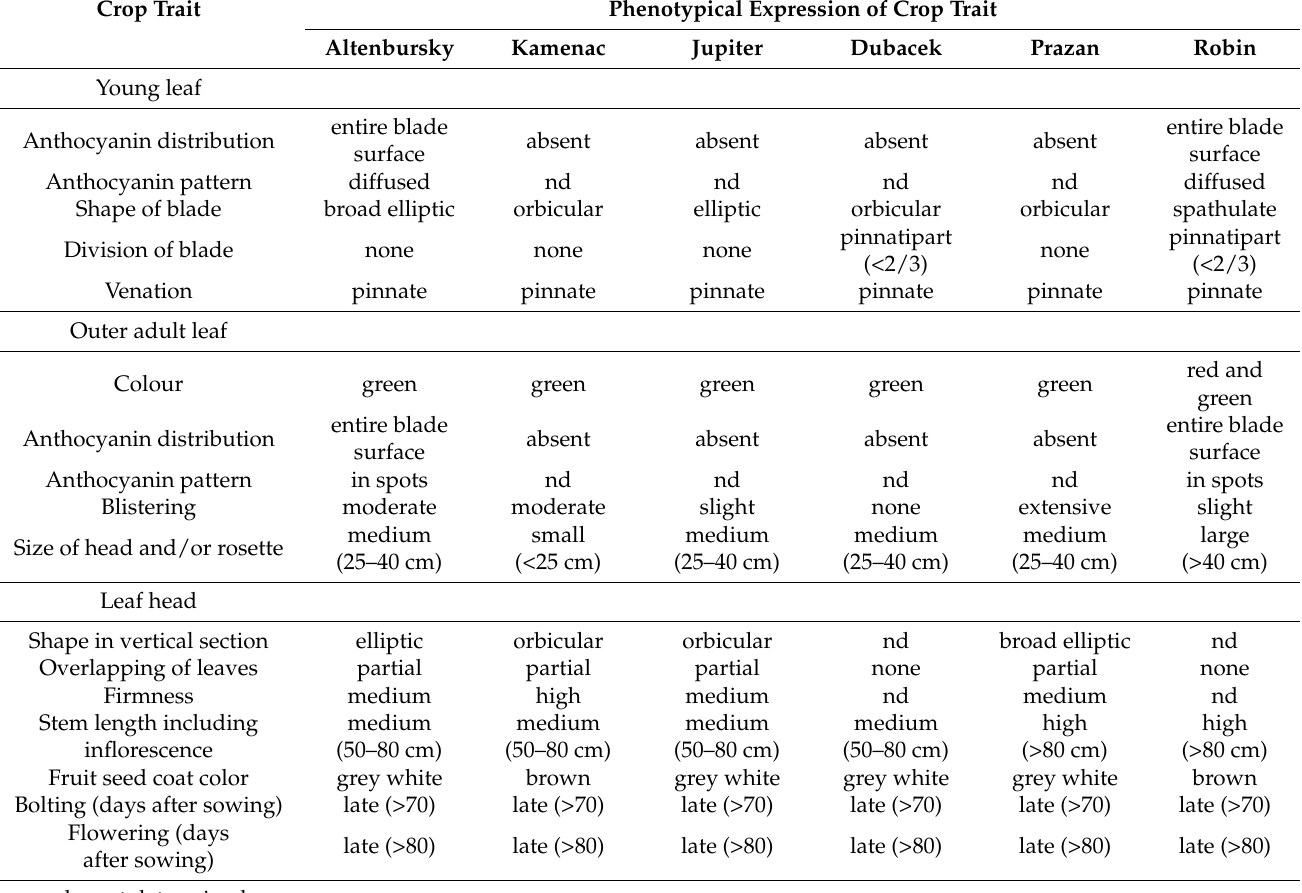
Table 2. Morphological and phenological traits of lettuce cultivars following the Descriptors List for Lactuca sativa L.